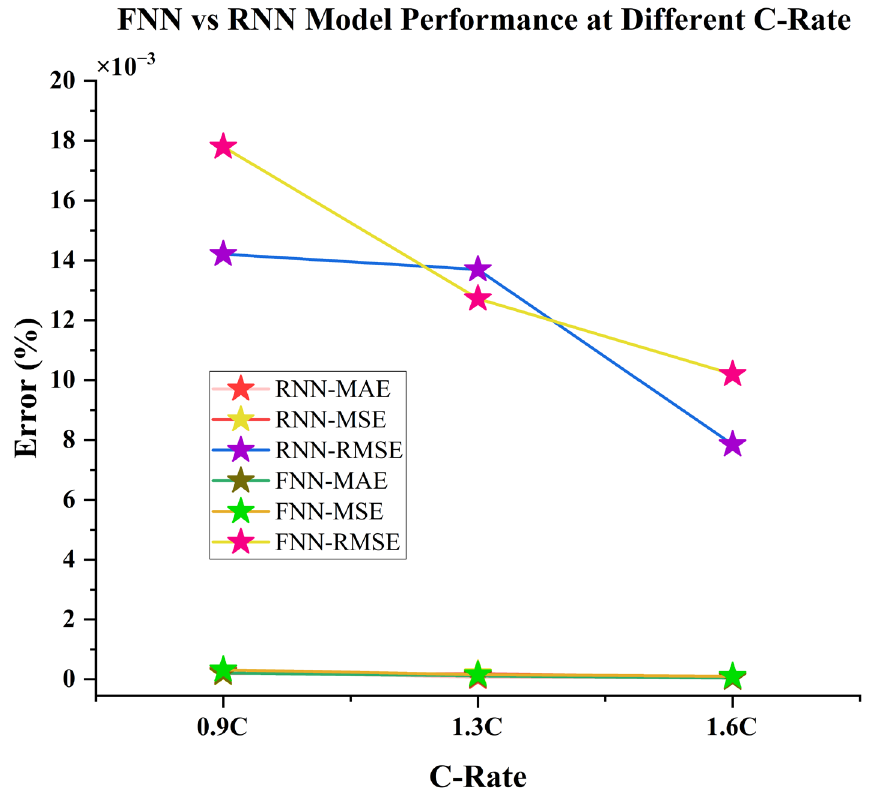
Figure 12. Comparison of the performance of RNN and FNN degradation models at 3 separate accelerated discharge rates: 0.9C, 1.3C, and 1.6C on the basis of MAE (%), MSE (%), and RMSE (%) values.